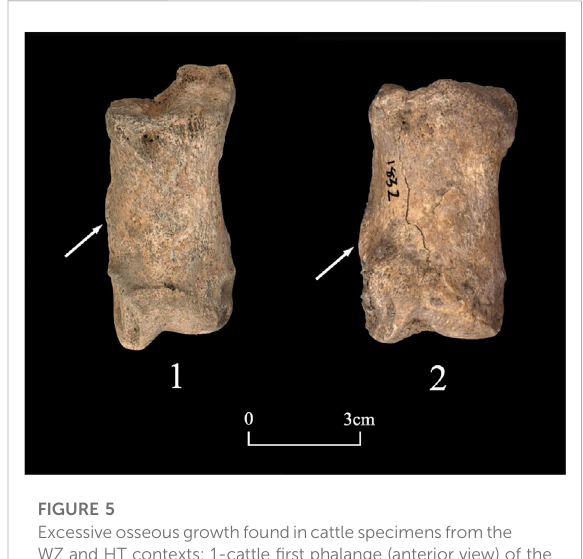
FIGURE 5 Excessiveosseousgrowthfoundincattlespecimensfromthe WZ and HT contexts: 1-cattle fi rst phalange (anterior view) of the WZ period; 2-cattle fi rst phalange (anterior view) of the HT